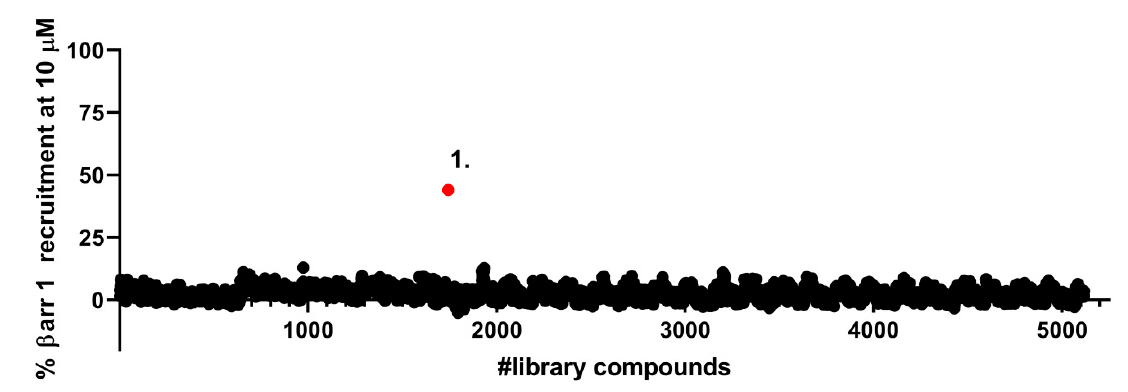
Figure 2. Screening of a CNS-targeted compound library for β -arrestin 1 recruitment at δ OR . 5200 compounds from sixteen 384-well plates from diverse CNS-targeted drug libraries were tested at 10 µ M for β -arrestin 1 recruitment at δ ORs in a PathHunter assay. The red dot represents the hit compound ( 1 ). 10 µM SNC80 was utilized for normalization.